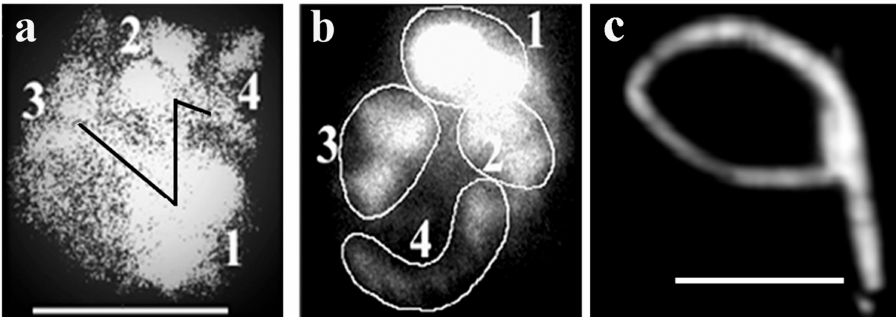
Figure 8. Determination of linear order of chromosome attachment in Drosophila nuclei. Chro- mosomes are numbered based on their size. Two sets of interphase chromosomes representing different stages of condensation are seen in panels ( a , b ). Pairs of chromosomes are circled in ( b ). Condensed Drosophila nuclear material without well distinguishable chromosomes ( c ). Bar 5 µ m, each. Modified with permission from Ref. [30]. Copyright year 2009, Springer, Dordrecht. Figure 3.38 of this reference.